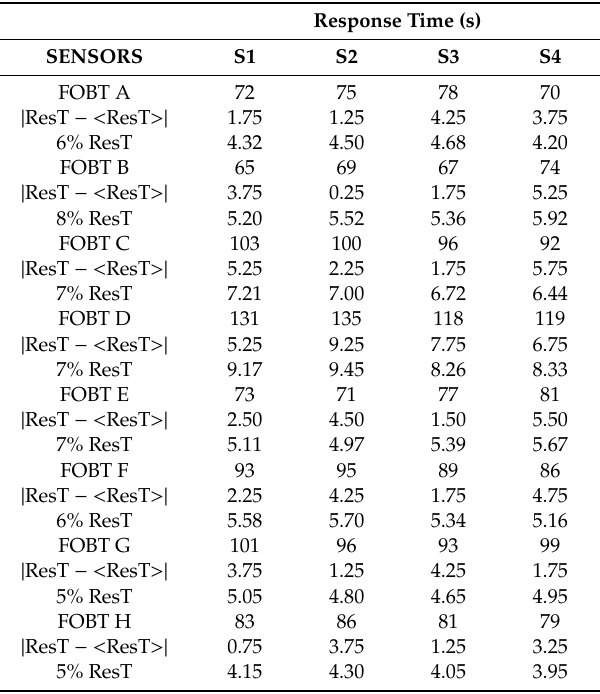
Table 6. Response times (ResT) to eight FOBT-positive fecal samples; absolute distance from mean value ( | ResT − < ResT >| ); and percentage of ResT below which the value of ( | ResT − < ResT >| ) stands for all sensors.